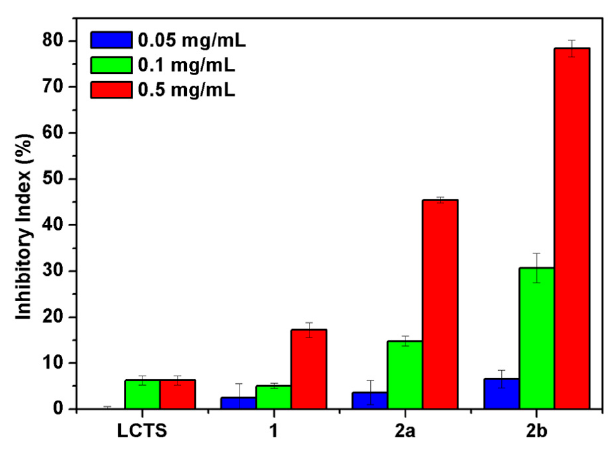
Figure 6. The antifungal activity of chitosan and chitosan derivatives against P. asparagi .